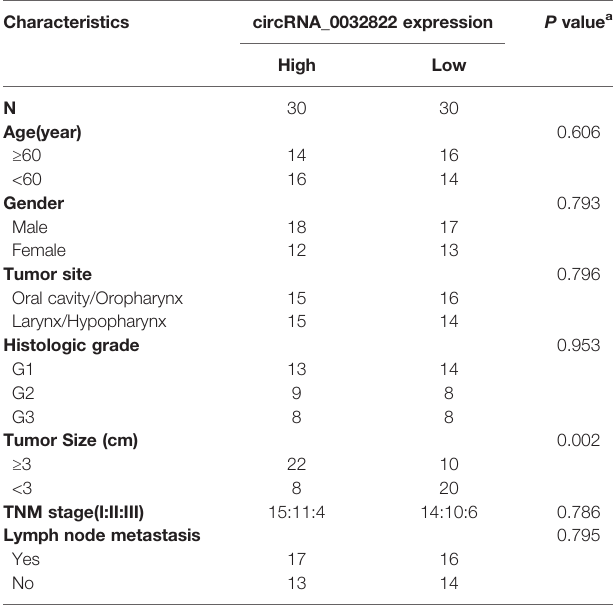
TABLE 1 | Correlation between circRNA_0032822 expression and clinicopathological parameters in head and neck squamous cell carcinoma (HNSCC)